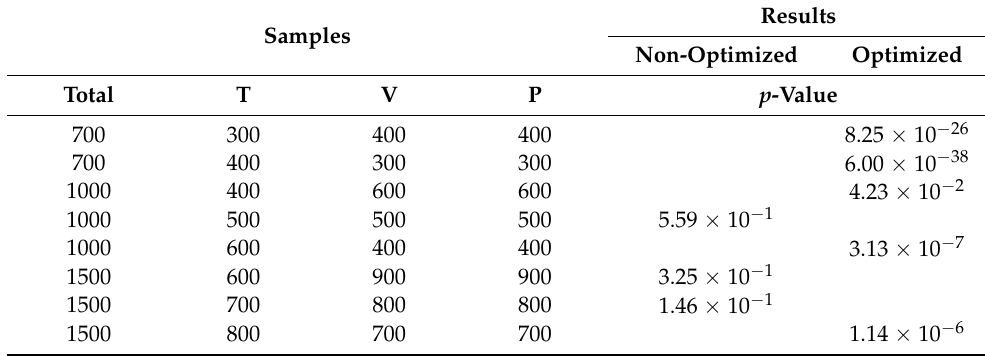
Table 8. Error comparison with three different methods and the non-optimized and optimized NARNN.